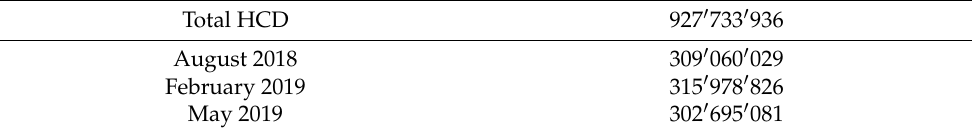
Table 3. HCD sample within the Veneto Region in the three analyzed